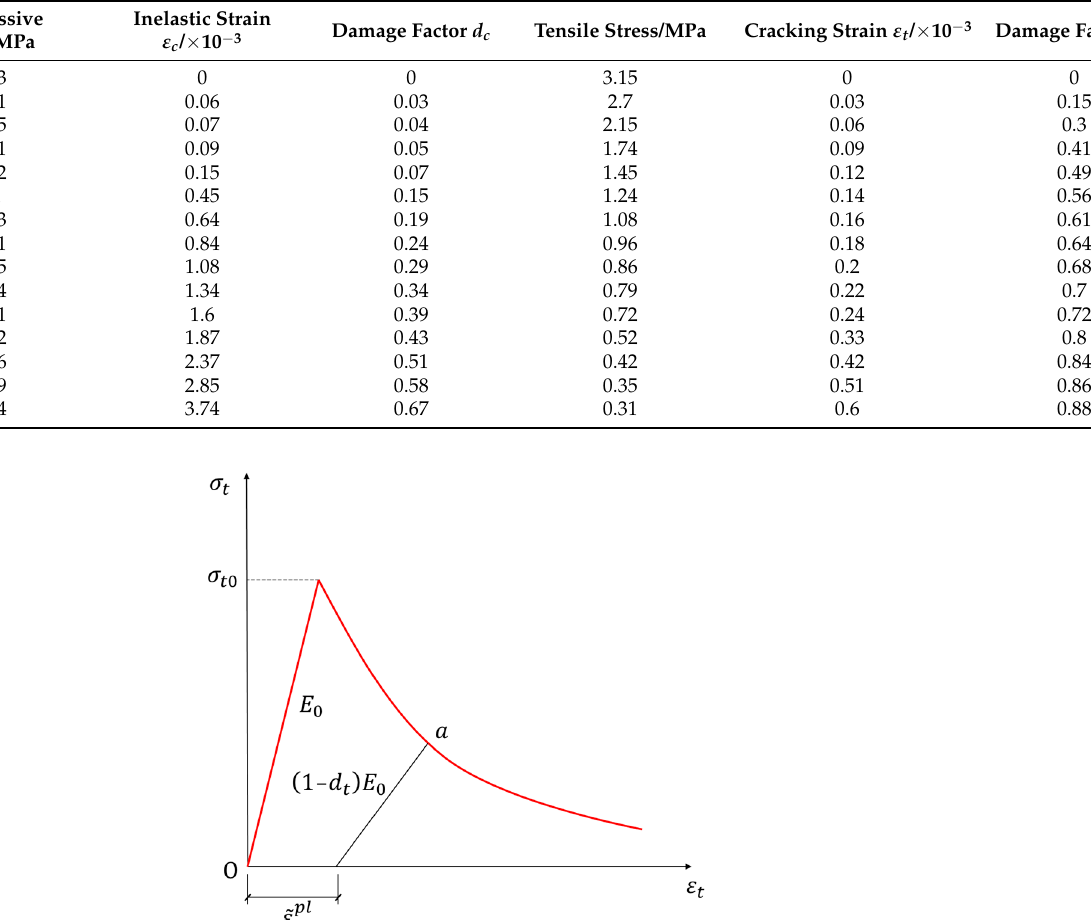
Table 3. Parameters of the concrete constitutive model.